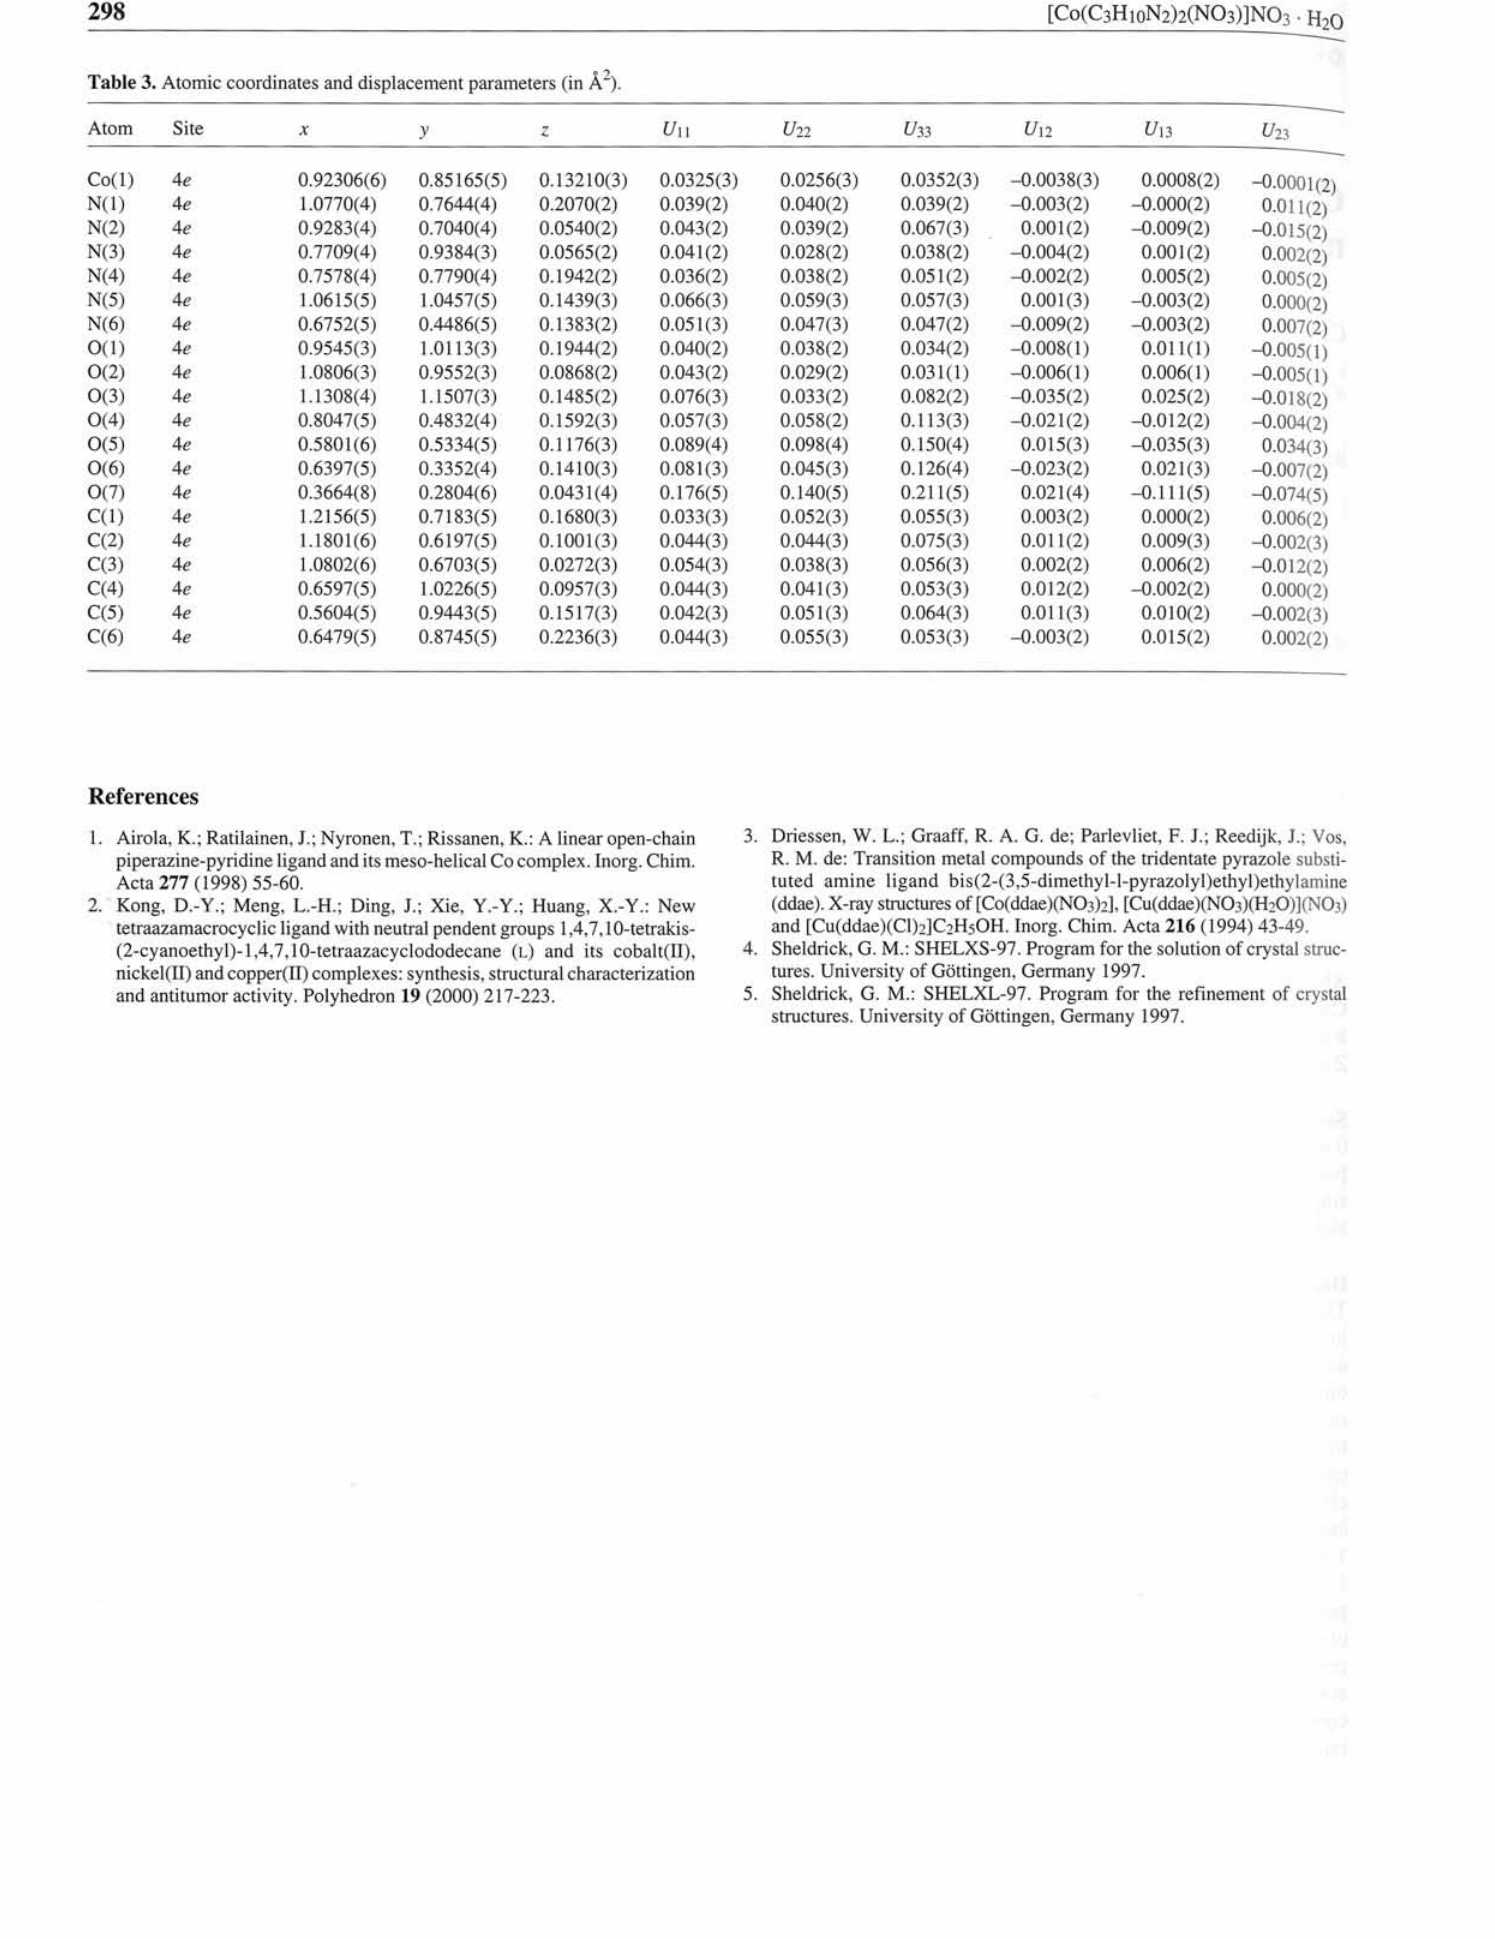
Table 3. Atomic coordinates and displacement parameters (in À 2